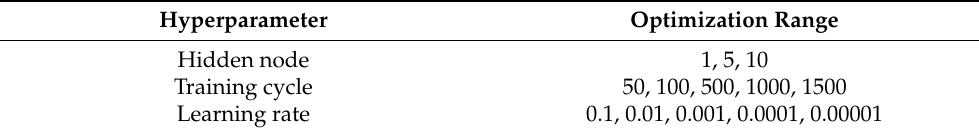
Table 8. The optimization range of ANN